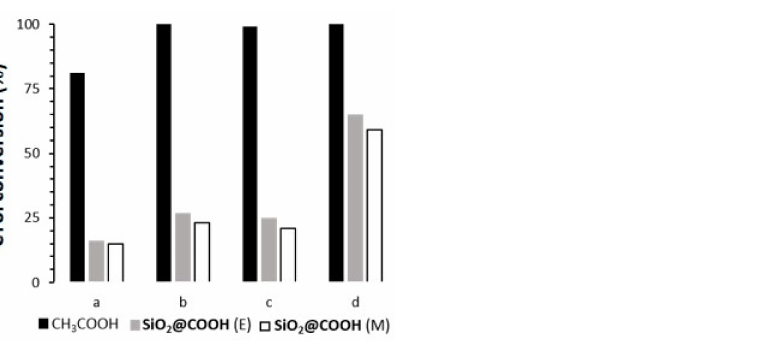
Figure 18. Comparison of CYol conversion (%) between different catalysts ( L )MnCl 2 ( a ), ( L )Mn(OTf) 2 ( b ), ( L )Mn( p -Ts) 2 ( c ), ( L )FeCl 2 (FeCl 4 ) ( d ) and different co-reagents. Reaction time: 3 h with CH 3 COOH, 5 h with SiO 2 @COOH . Table 6. Relevant data for the catalyzed oxidation of cyclohexanol (a) .